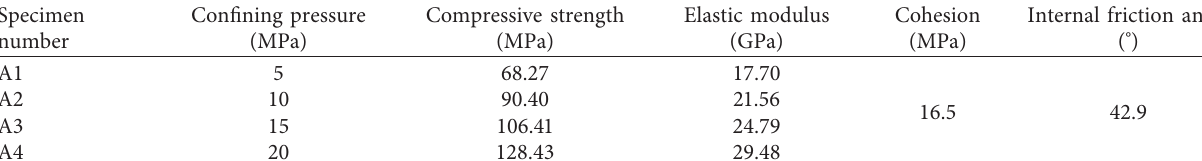
Table 5: Triaxial test results for mudstone.